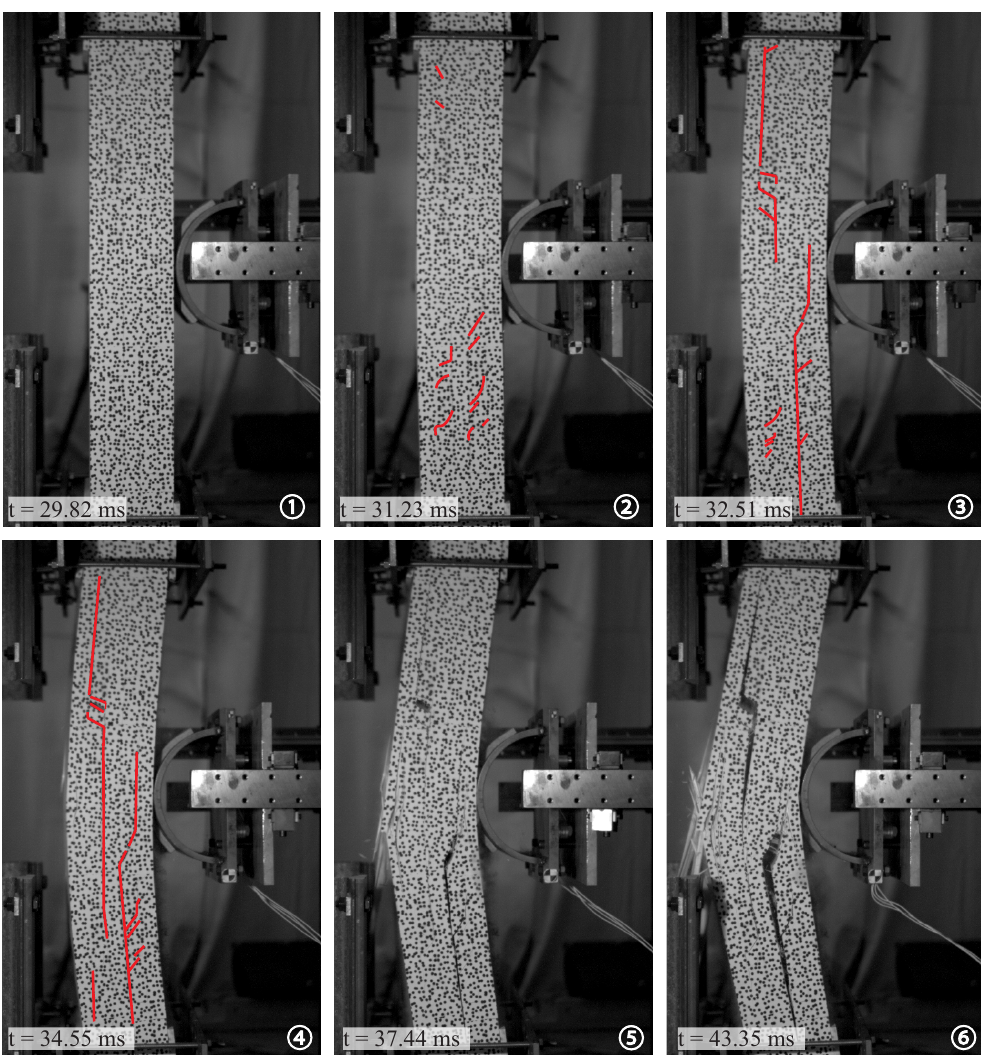
Figure 23. CLT5-10 Damage progression.